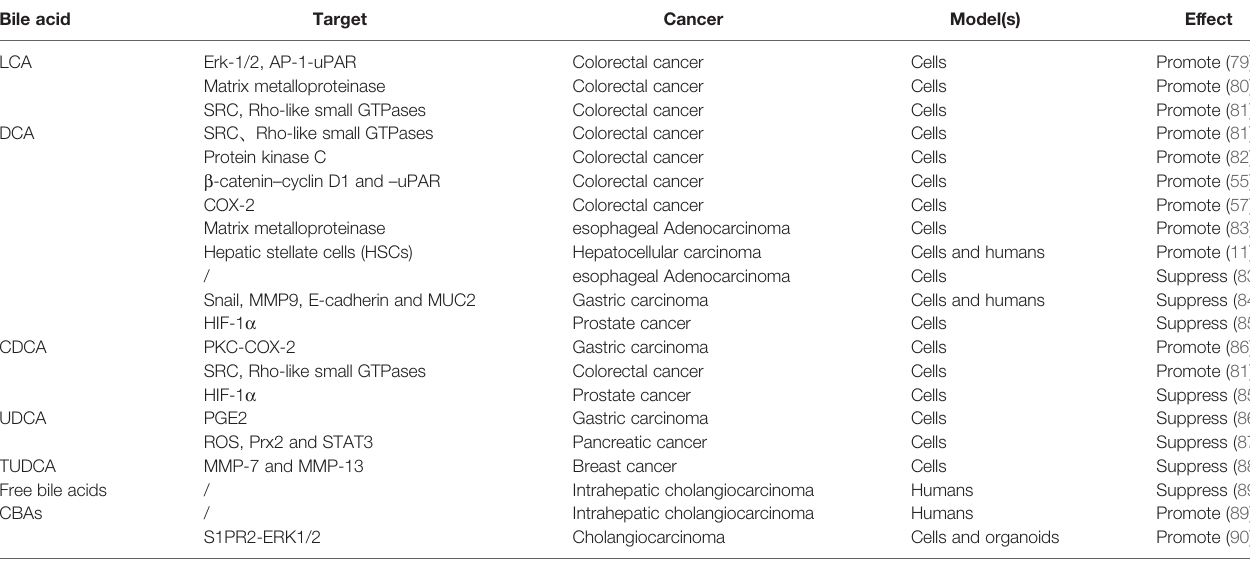
TABLE 3 | The impact of bile acid on cancer cell Invasion and metastasis. Bile